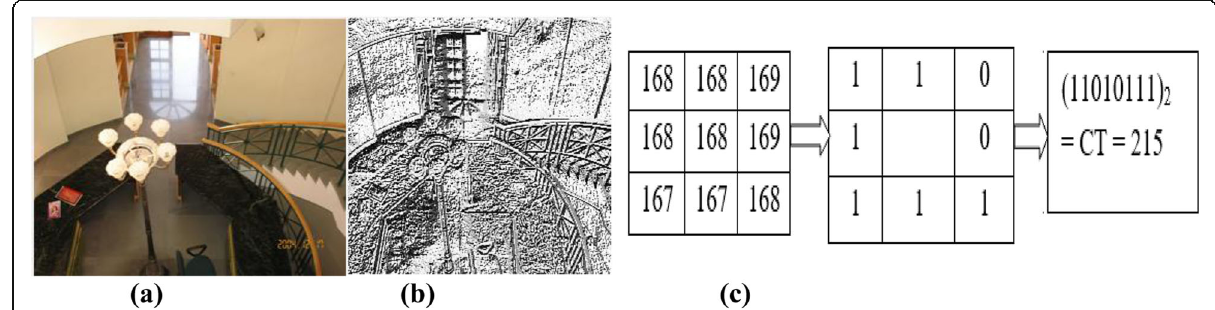
Fig. 3 Census transformed output. a Indoor image; b Census transformed Indoor image; c Census transformed